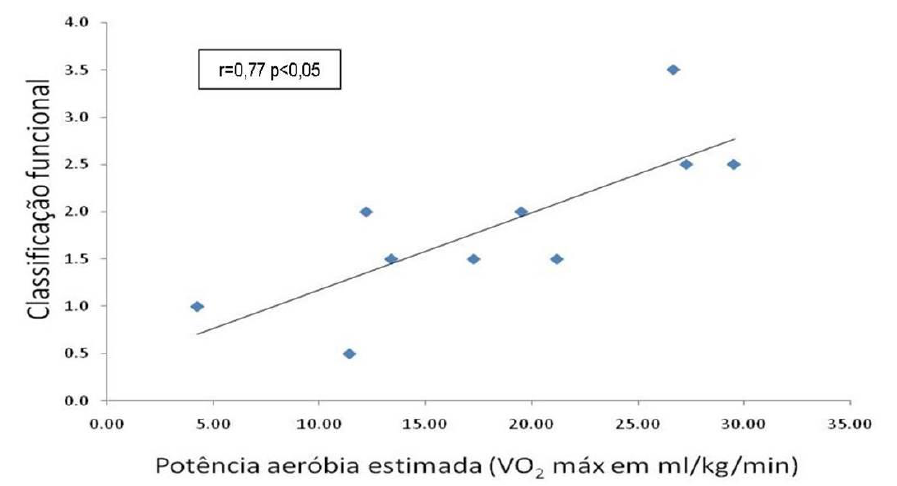
Figura 2. Correlação entre a classificação funcional e os valores de potência aeróbia